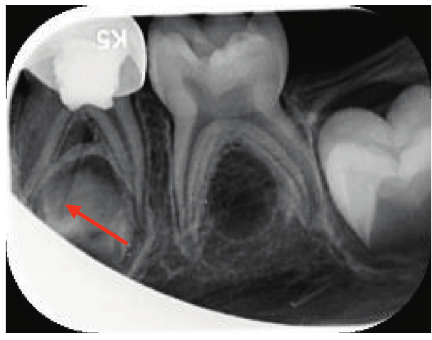
Figure 3: Periapical radiograph showing third root in left man- dibular first primary